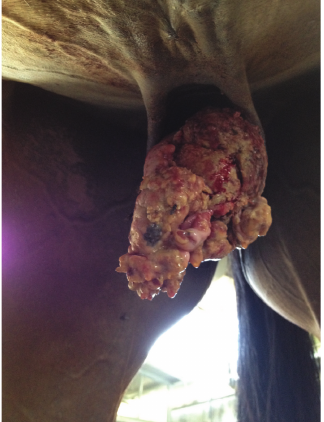
Figure 1: Macroscopic appearance of the penile mass at admission showing a florid, cauliflower-like ulcerated mass disrupting the normal anatomy of penis and